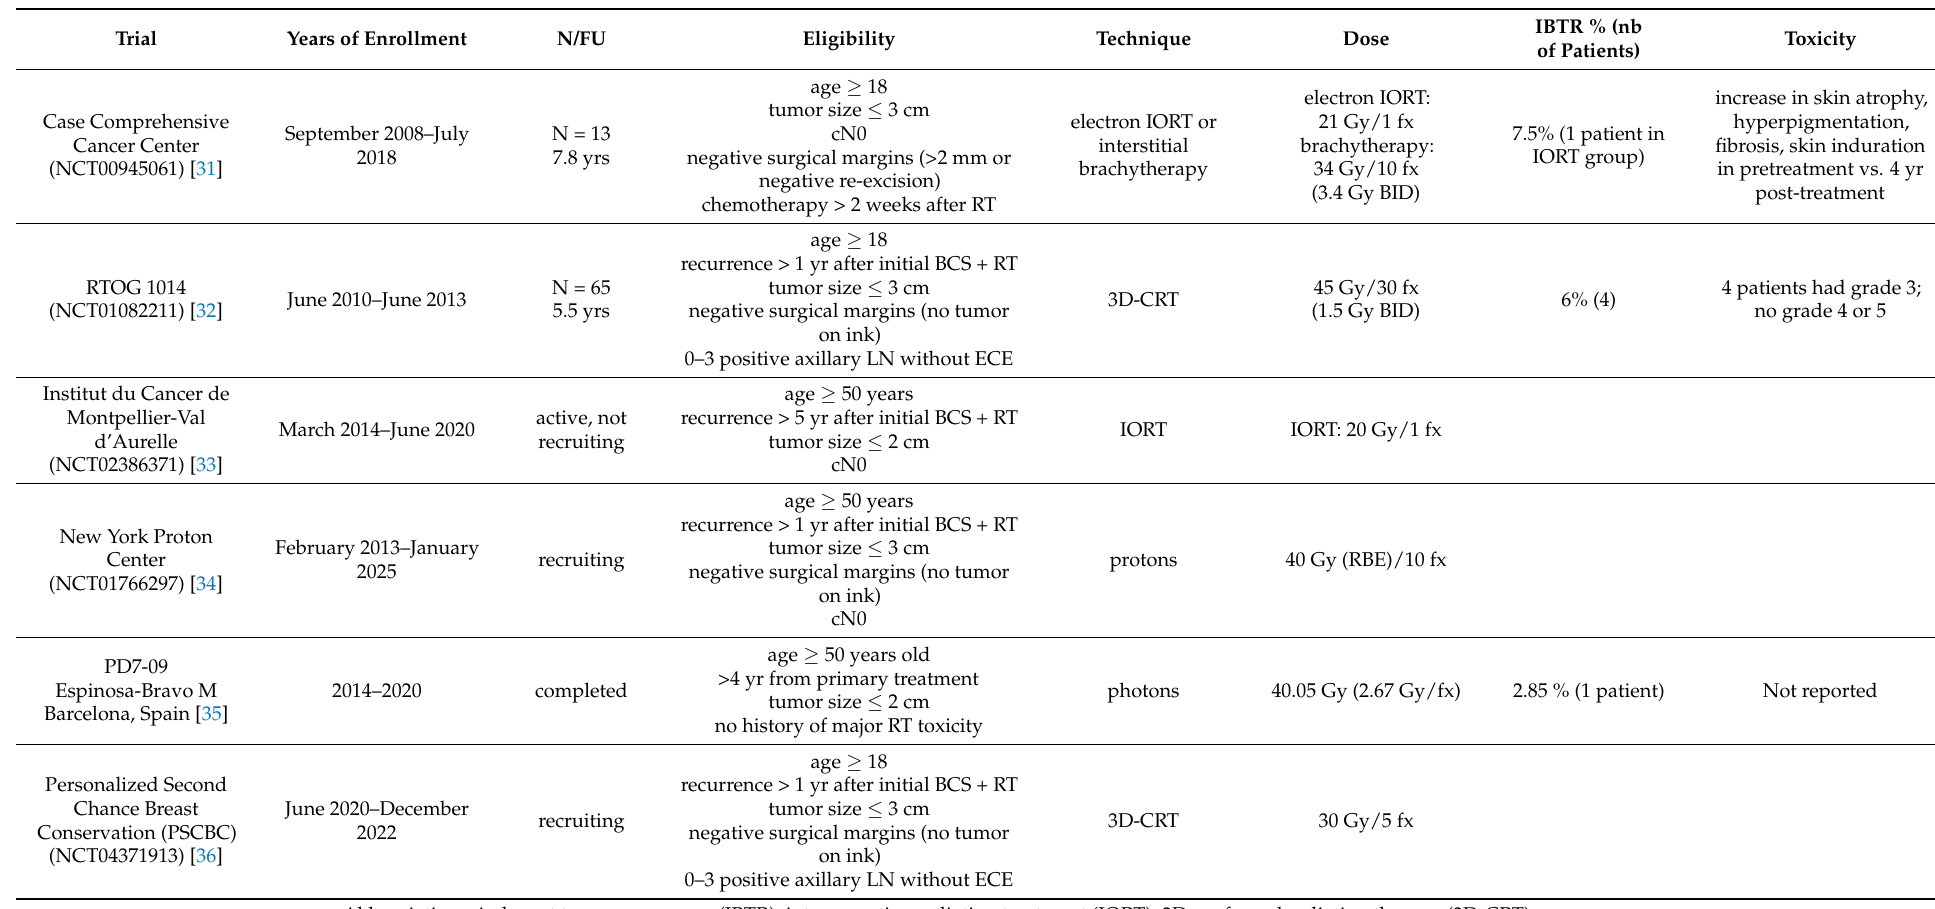
Table 3. Prospective breast re-irradiation trials (corresponds to sect ion 3.3 in